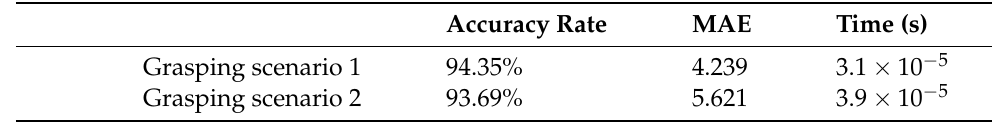
Table 3. The effect of pre-planners in two grasping scenarios.